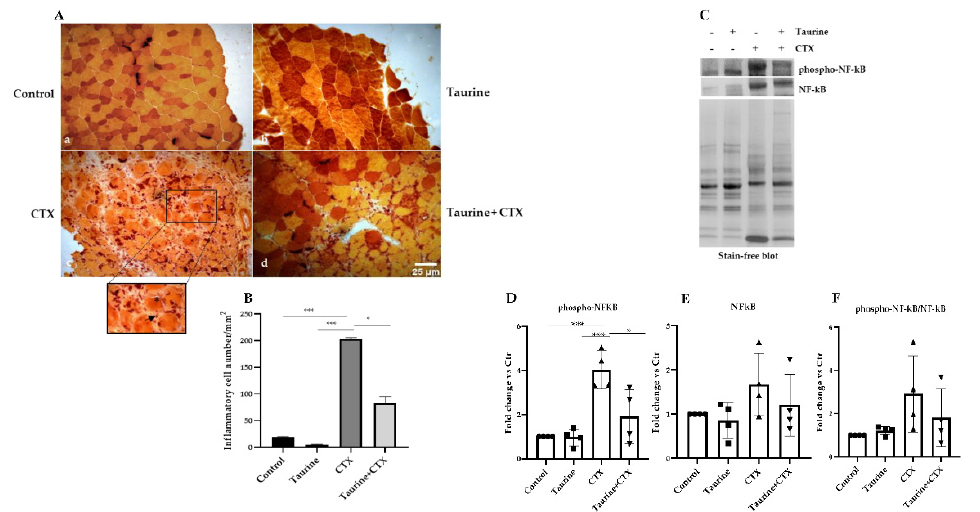
Figure 2. Taurine attenuates inflammatory processes in damaged skeletal muscles of aged mice. ( A ) Nonspecific esterase staining was performed on transverse cryosections of TA muscles of aged mice (original magnification X20). Panel a, Control; panel b, Taurine; panel c, CTX; panel d, Taurine+CTX. Inflammatory mononucleated cells are highlighted by an arrow; necrotic fibers are highlighted by an asterisk. ( B ) Graph values represent the mean ± SEM of the number of inflammatory cells per unit area in muscle cross-sections. ( C ) Western blotting analyses of total lysates were carried out to evaluate the levels of phospho-NF-kB and NF-kB. A representative blot is shown. ( D – F ) The graphs show the densitometric analysis of the phospho-NF-kB and NF-kB levels and the phospho-NF- kB/NF-kB ratio, performed by using a stain-free blot to verify the sample loading. Statistical analysis was performed by one-way ANOVA multiple comparisons, * p < 0.05, *** p < 0.001, n = 4 mice per group. Data are represented as mean ± SEM. •, ■ , ▲ and ▼ represent samples from control, taurine- , CTX-, taurine+CTX-treated groups.